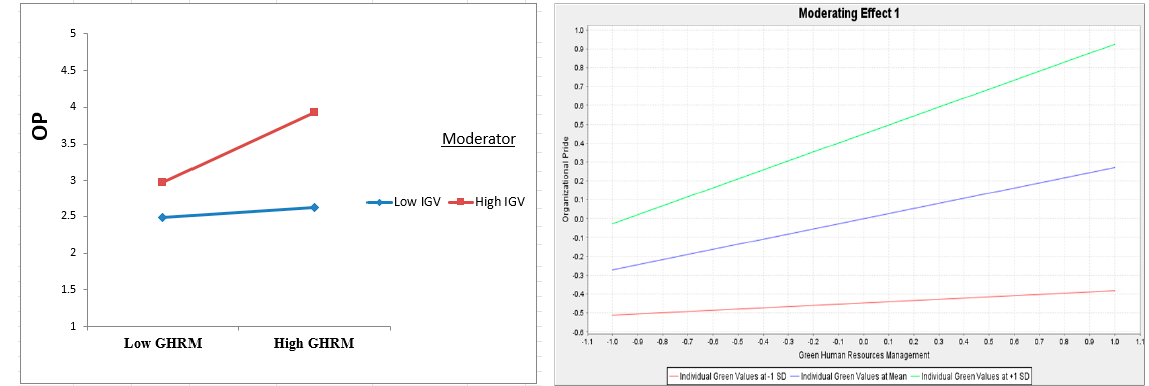
Figure 3. Interaction-plot (IGV moderation between GHRM and OP).